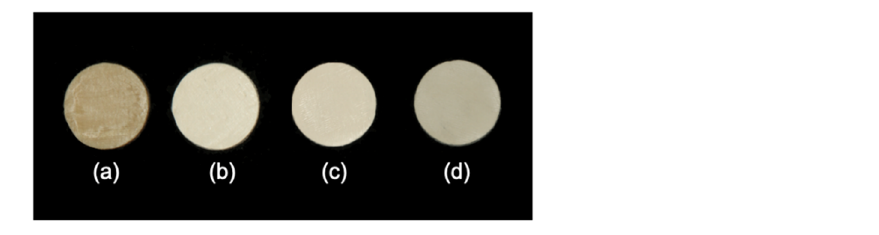
Figure 7. 3D printed PEEK with tooth-like colors. ( a ) pure PEEK for contrast; ( b ) D1 (5% TiO 2 /PEEK);